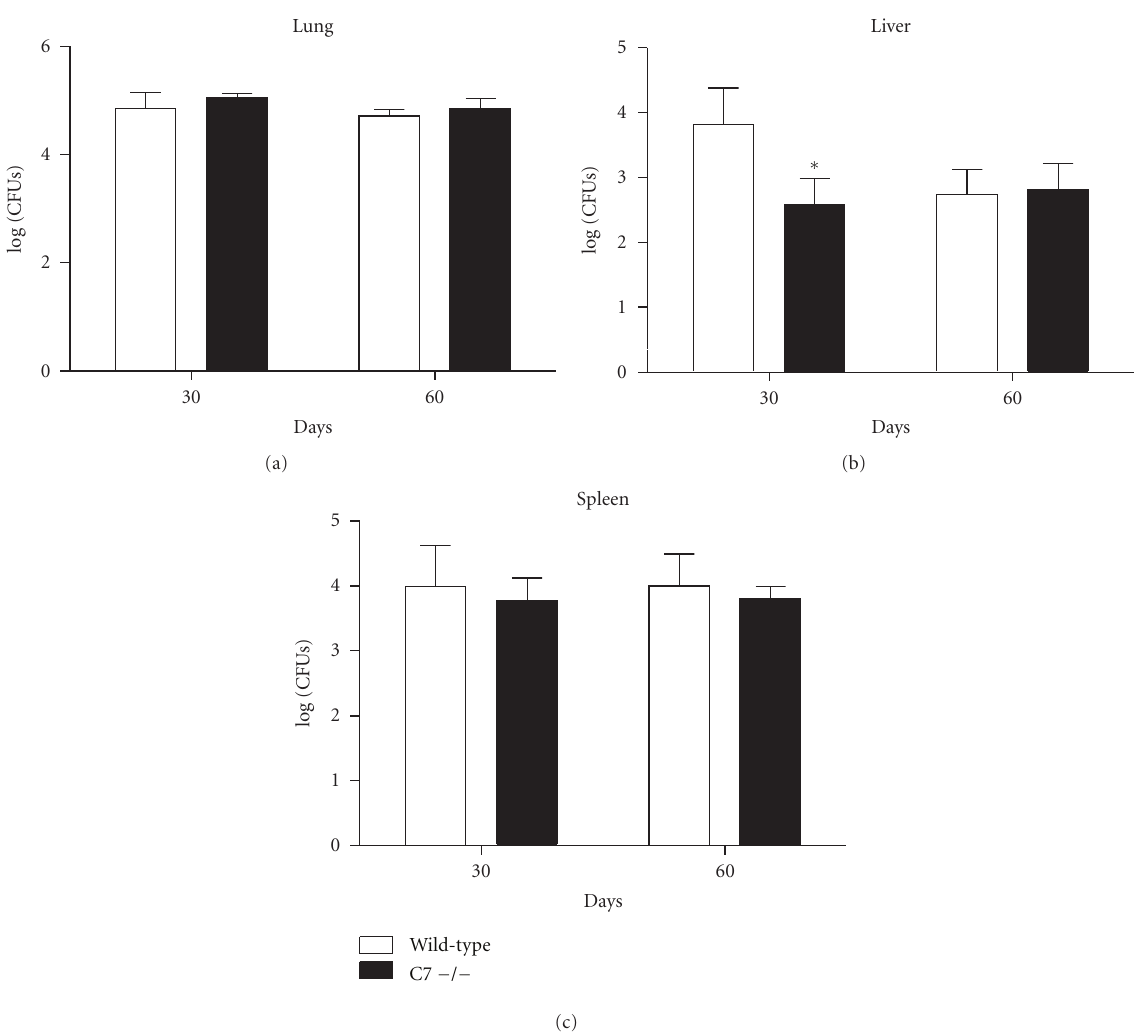
Figure 1: Decreased early bacterial dissemination to the liver in C7 − / − mice. C7 − / − mice had significantly reduced bacterial CFUs in the liver at day 30 after infection with MTB. There were no di ff erences in bacterial burden in the lung or spleen. ∗ P < 0 . 05 with comparison to wild-type C57BL/6